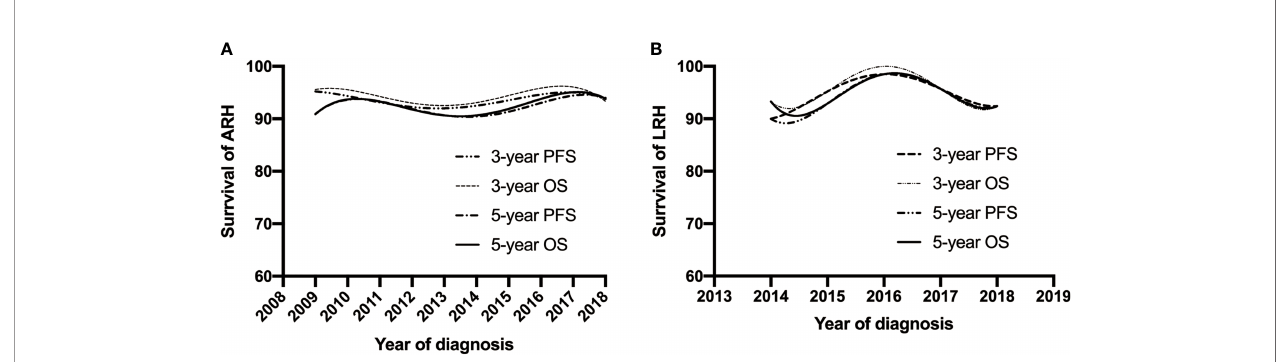
FIGURE 4 | Trends of the OS and PFS adjusted for clinicopathological factors for patients with open approach (A) and MIS approach (B) of early-stage cervical cancer over the past 11 years. MIS, minimally invasive surgery; OS, overall survival; PFS, progression-free